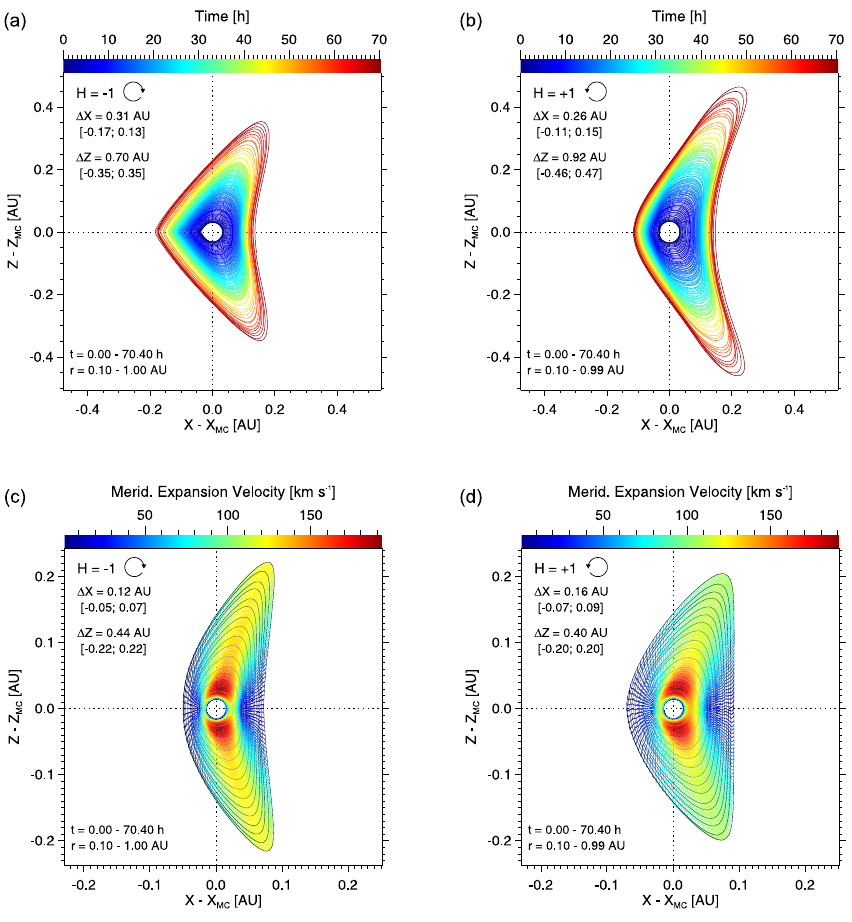
Fig. 14. The outermost “closed” magnetic field line as a function of time for H − m (a) and H + m (b) . The lower row presents the hydrodynamic expansion velocities along the various paths of 180 test particles inside H − m (c) and inside H + m (d) (see text). Gray contours are drawn every